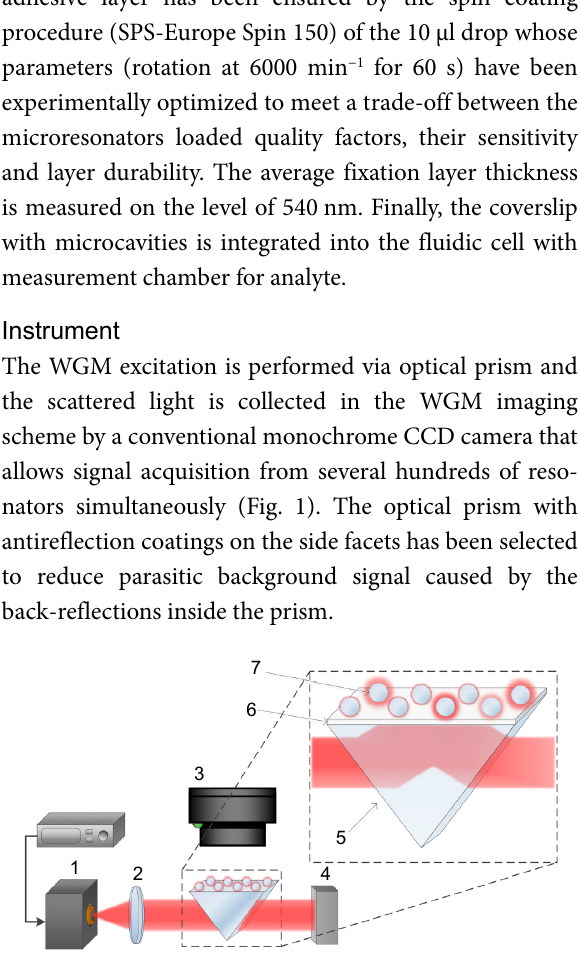
Fig. 1 | Overview of the instrument configuration: 1 - laser diode; 2 - collimation lens; 3 - camera; 4 - beam dump; 5 - right angle optical prism; 6 - adhesive thin layer; 7 - microresonator.